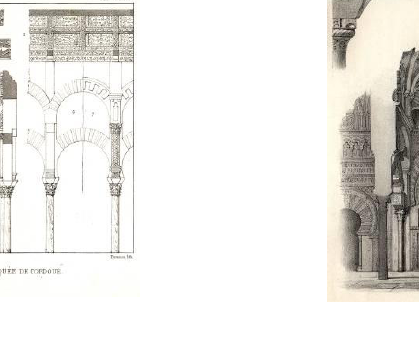
( b ) Figure 11. Girault de Prangey: ( a ) Details and mosaics (Dumouza, lit.); ( b ) Arabic inscriptions (Asselineau, lit.). Source: Essai sur l’architecture des Arabes et des Mores, en Espagne... 1841. Furthermore, in Jules Gailhabaud’s work, “Monuments anciens et modernes...” (c. 1845) [38], there are five plates of the Mosque-Cathedral: three views copied from other authors; one with a general plan and section including details, drawn by J. Jourdan and based on Prangey (Figure 12a); and another with details drawn by Prangey and Niel (Fig- ure 12b). ( a ) ( b ) Figure 12. Girault de Prangey: ( a ) General plan and section and details from the Mosque (Jourdan, dib.; Bury, eng.); ( b ) Mosque details (Prangey, dib.; Niel, dib.; Bury, eng.). Source: Monuments anciens et modernes... c. 1845.